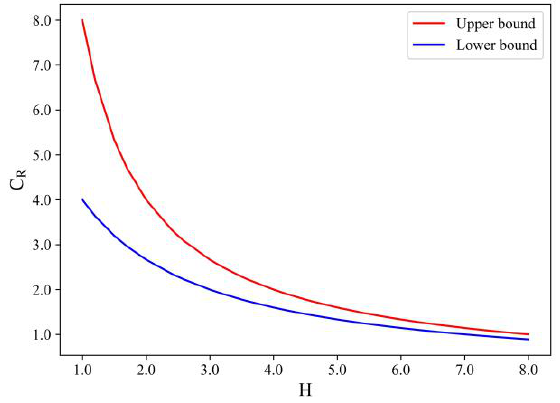
Figure 2. Shannon’s source coding theorem on compression